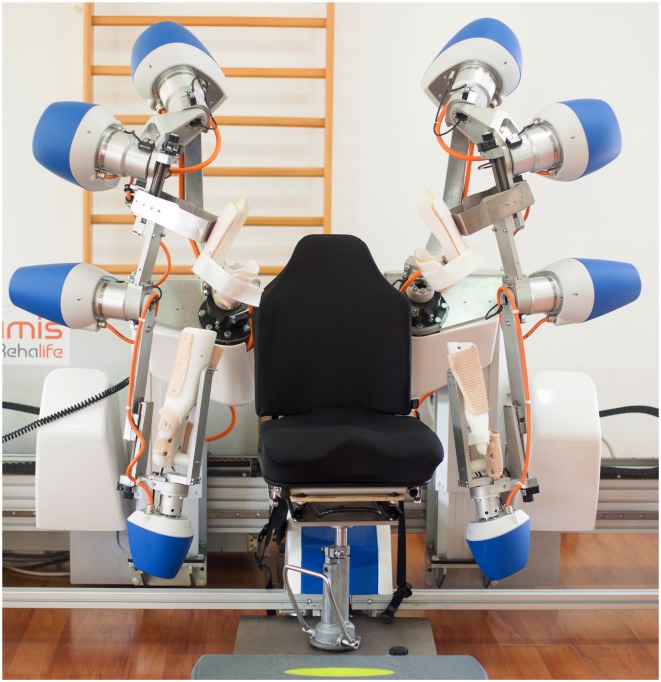
The robotic-assisted device called Automatic Recovery Arm Motility Integrated System (ARAMIS).